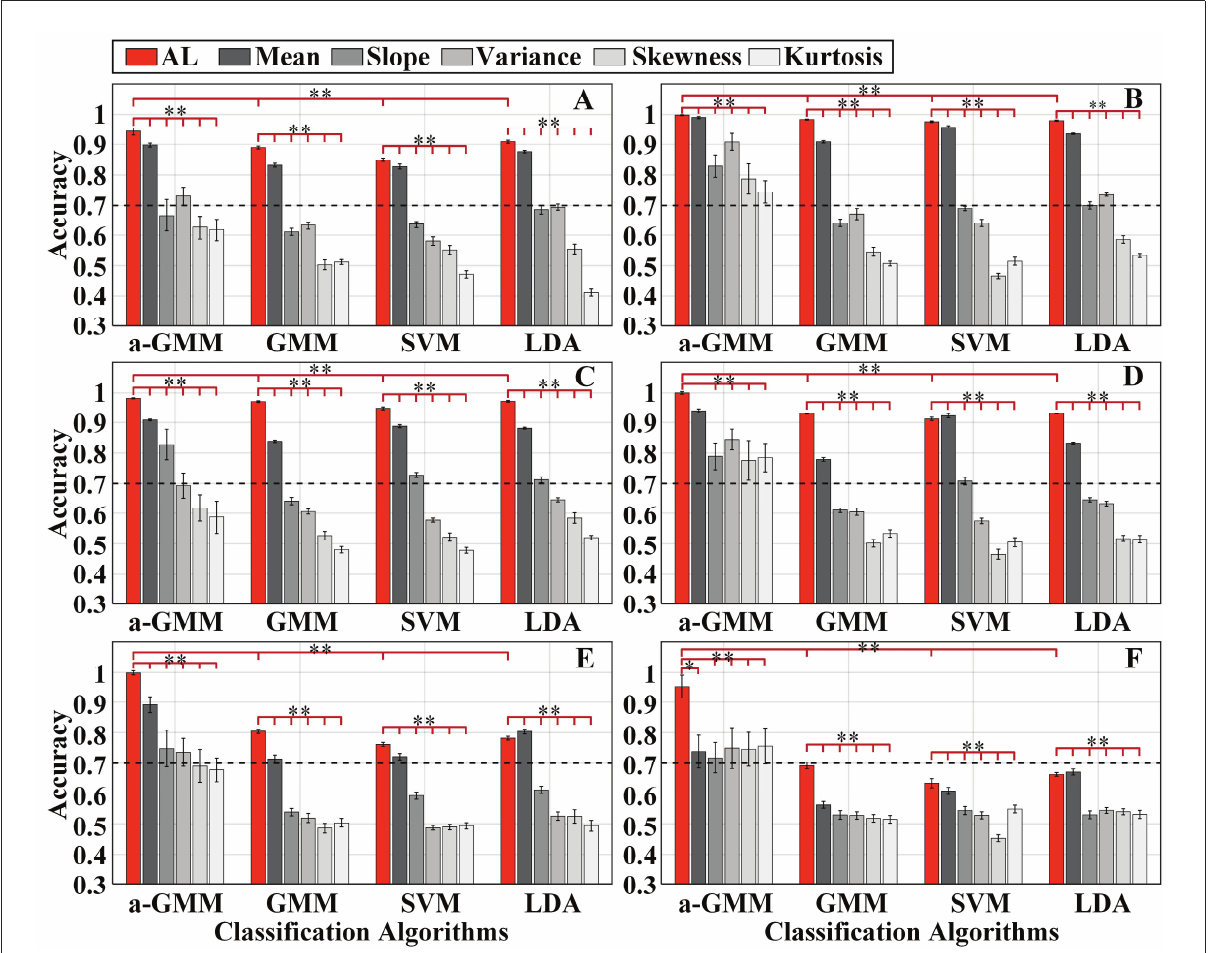
FIGURE6 The single-trial average accuracy of six simulations with randomly varying activation patterns of the brain under Gaussian white noise with SNR = 10 dB added at the baseline: (A–F) Are the accuracy results of simulations 1–6, respectively. AL is an abbreviated form of activation level. The red bars indicate accuracy based on the activation level features, while the gray bars with different saturation levels indicate the accuracy based on five BPF-statistical features, namely mean, slope, variance, skewness, and kurtosis. Error bars indicate the standard deviations, *Represents the significant difference, empty: p > 0.05, * p < 0.01, and ** p <